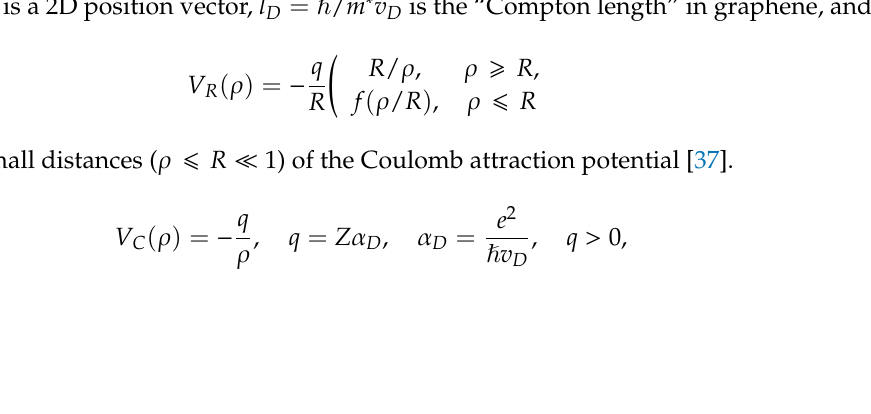
) of the Coulomb attraction potential [37].